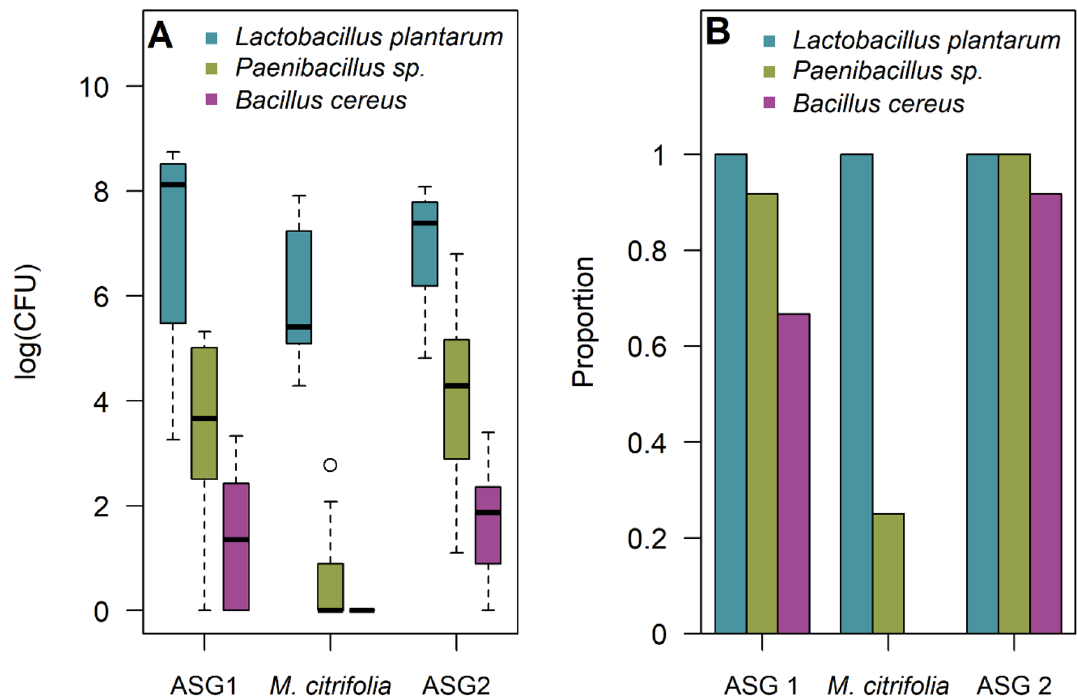
Figure 1. Variation in ( A ) the abundance (as measured by Colony Forming Units) of, and ( B ) the proportion of individuals harbouring L. plantarum , Paenibacillus sp. , and Bacillus cereus in the gut. Data is derived from gut dissections of adult D. sechellia that were fed on: (1) ASG for 1 week (ASG 1), (2) ASG for 1 week followed by M. citrifolia for 1 week ( M. citrifolia ), and (3) ASG for 1 week followed by M. citrifolia for 1 week before a final week of feeding on ASG (ASG